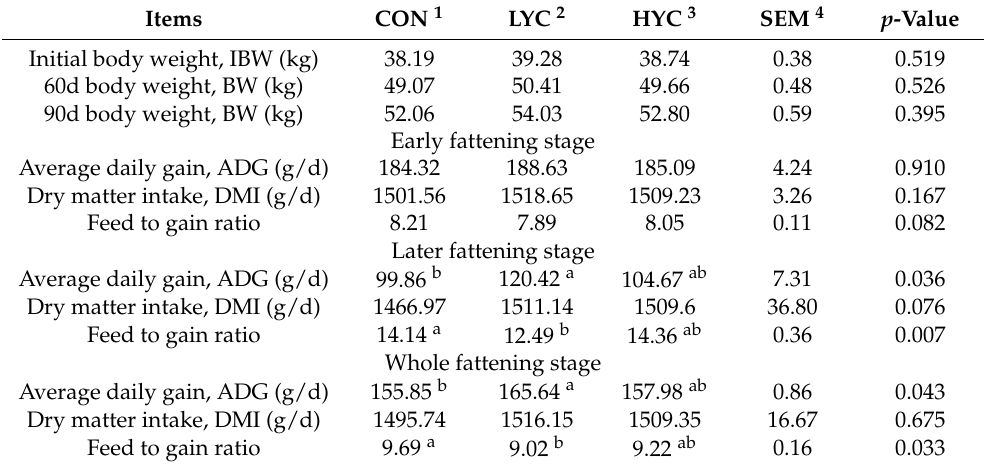
Table 2. Effect of dietary supplementation of YC on growth performance of fattening Hu sheep.